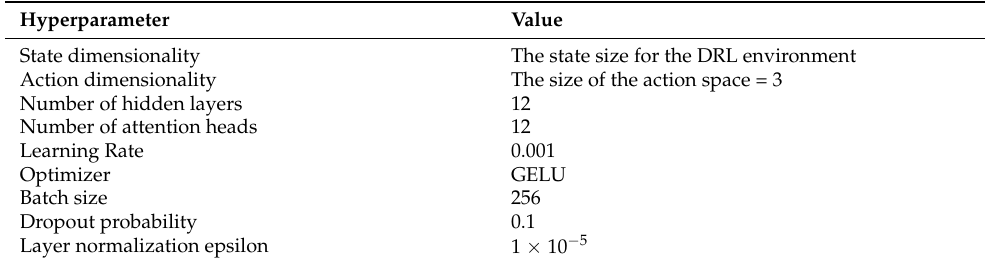
Table 3. Values of various hyperparameters used in our